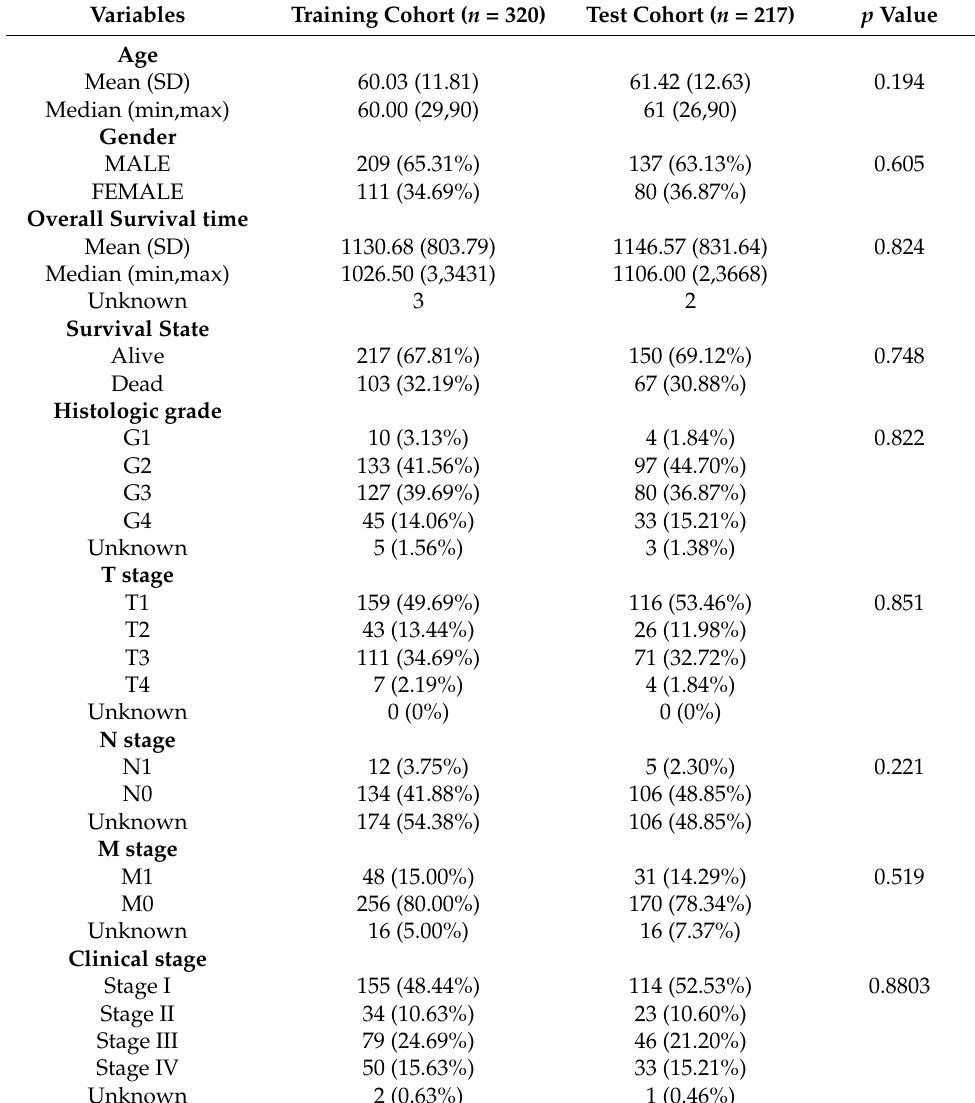
Table 1. Clinical characteristics of the ccRCC patients in Train and Test